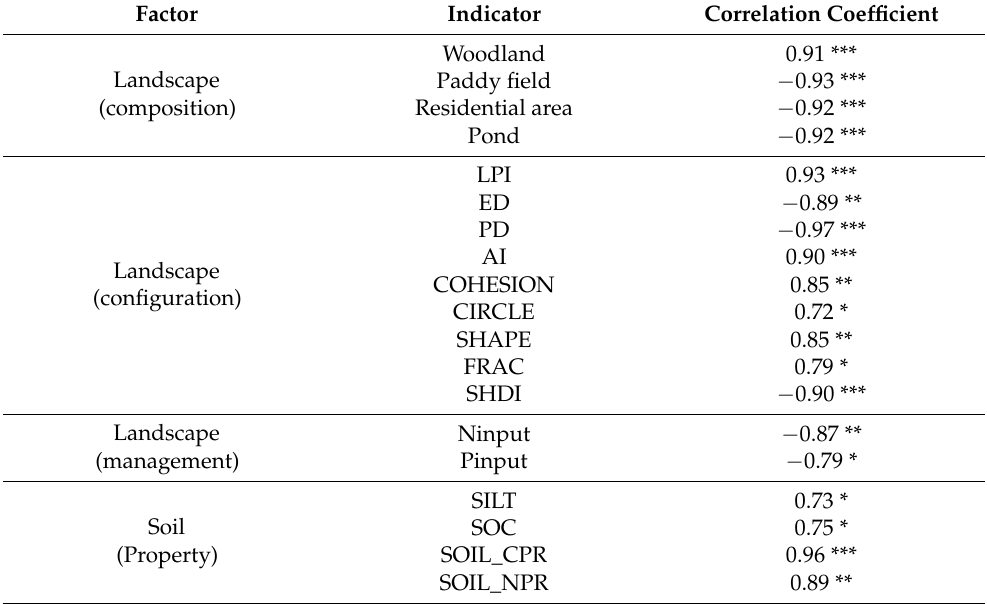
Table 6. Pearson’s correlation coefficients between the average elevation–relief ratio and the landscape and soil indicators of the nine studied catchments. *, ** and *** represent the statistical significance at the probability levels of 0.05, 0.01, and 0.001,